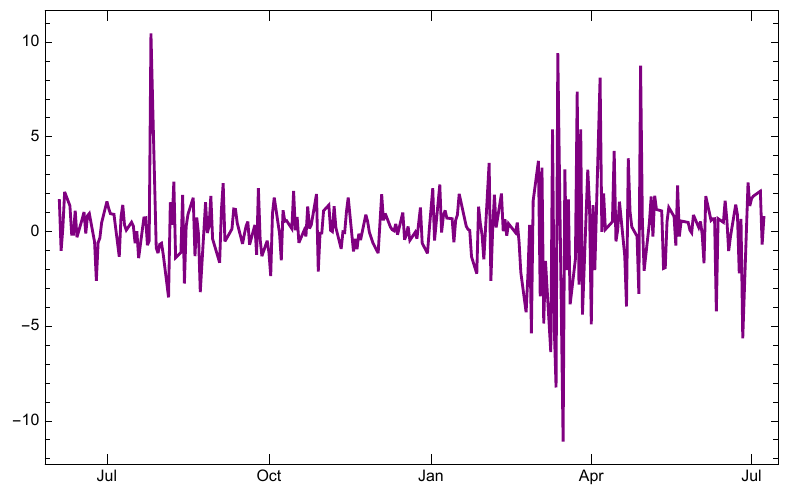
Figure 3. The daily returns of the NASDAQ:GOOG on the considered time